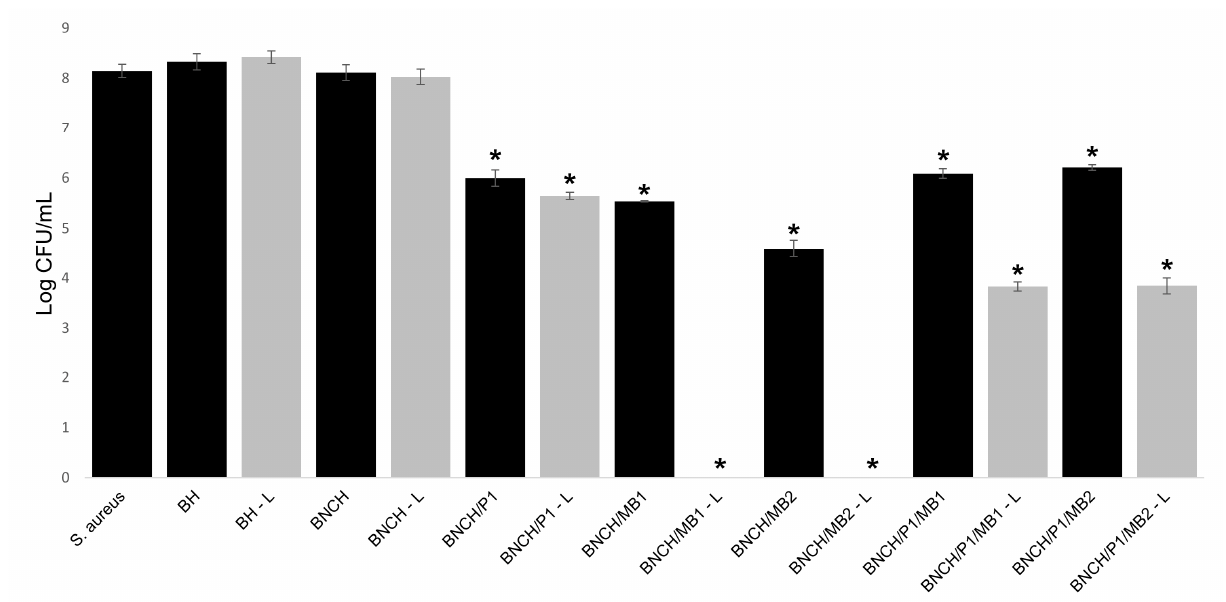
Figure 8. Antimicrobial activity of the formulations against S. aureus in protocols without light and after light exposure with a fluency of 50 J cm − 2 at 660 nm (L). Results are expressed as mean inhibition ± SD. Statistical analysis was performed with one-way ANOVA, and post hoc Tukey’s test revealed a significant reduction in S. aureus (* p < 0.05 vs. control S. aureus ). Table 4. Mean inhibition zone ± SD of S. aureus growth after treatment with the formulations in experiments in the dark and with light irradiation (50 J cm − 2 of red light at 660 nm). Statistical analysis was performed with one-way ANOVA, post hoc Tukey’s test revealed a significant increase in the inhibition zone (* p < 0.05 vs. control S. aureus